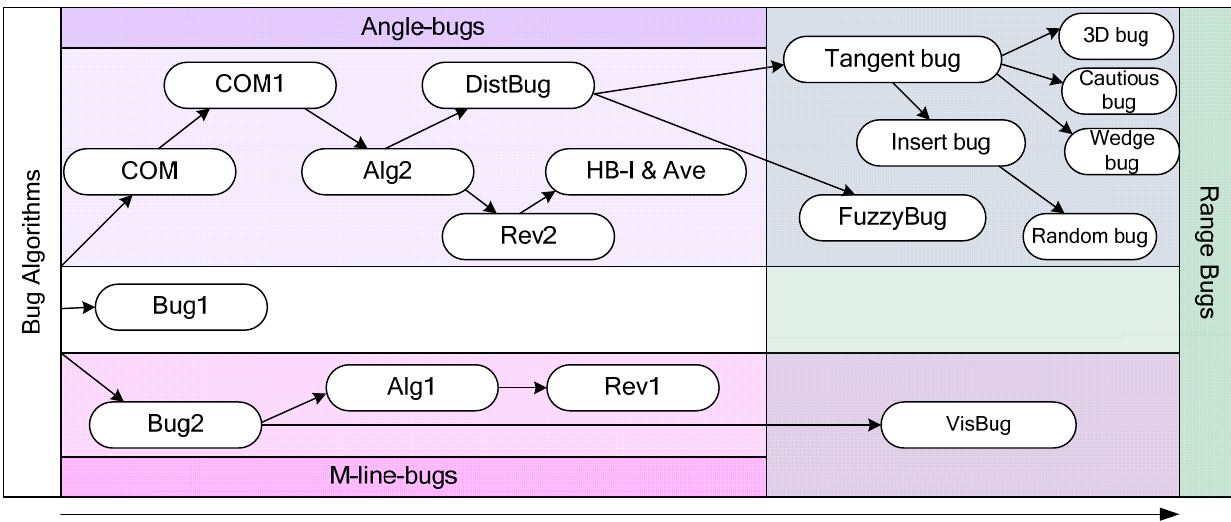
Figure 5. Bug-type algorithms classification.